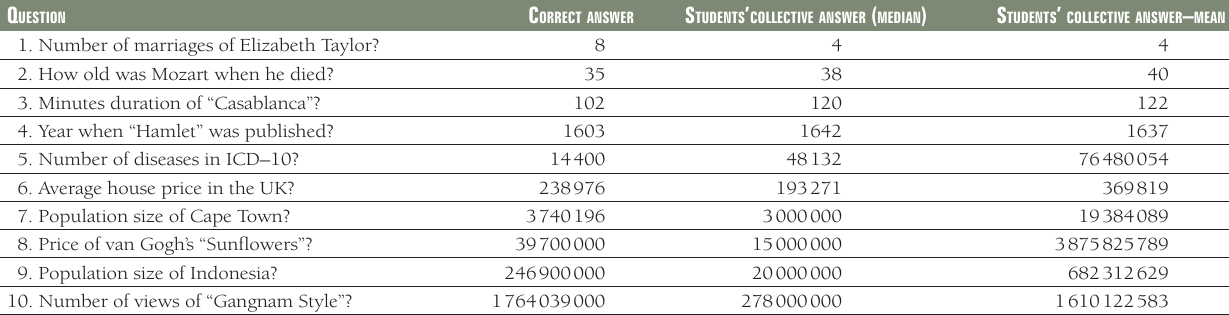
Table 4. Year 2 undergraduate medical students’ collective answers to the 10 questions in the area of general knowledge*